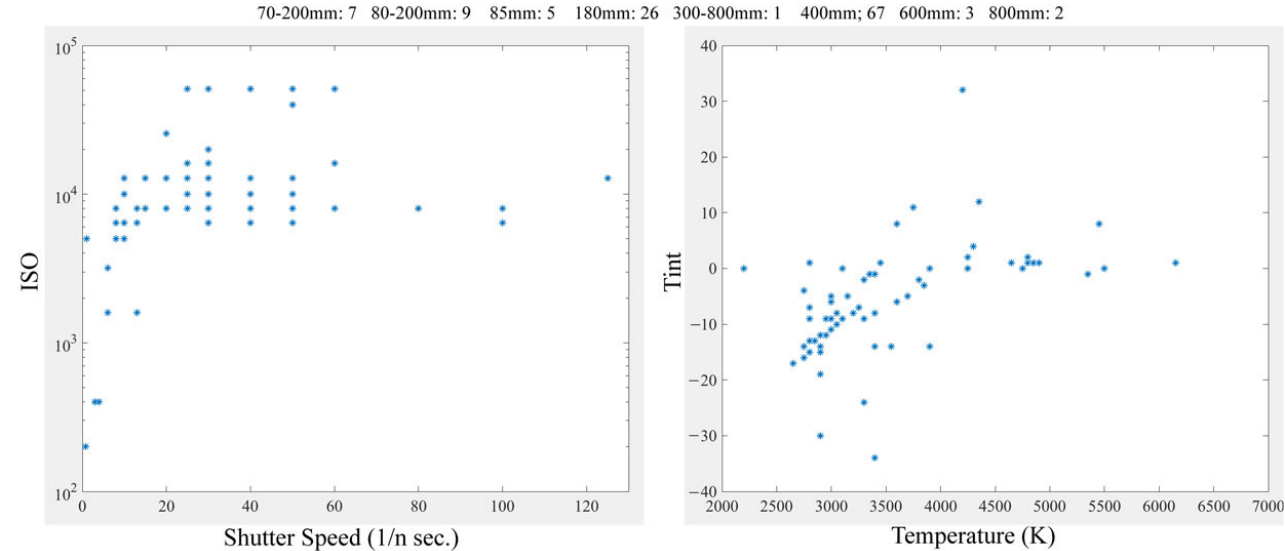
Figure 3. Exposure, ISO and white balance settings for 122 high-quality urban lightscape photos taken between 2003 and 2020. Most photos were taken with high ISO and relatively low shutter speed for the telephoto focal lengths of the lenses used (distribution at top). The distribution of white balance settings is skewed toward low temperatures consistent with the widespread use of high- and low-pressure Sodium light